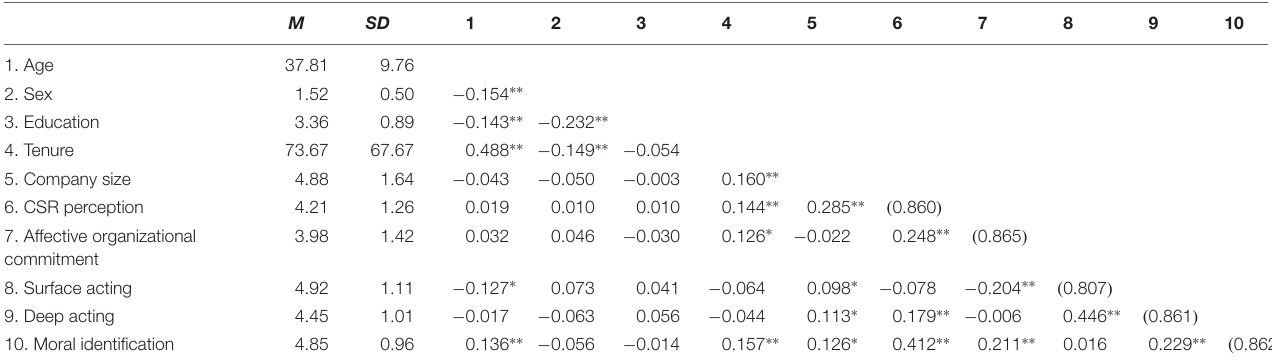
TABLE 1 | Means, standard deviations, reliabilities, and correlations among the study variables.